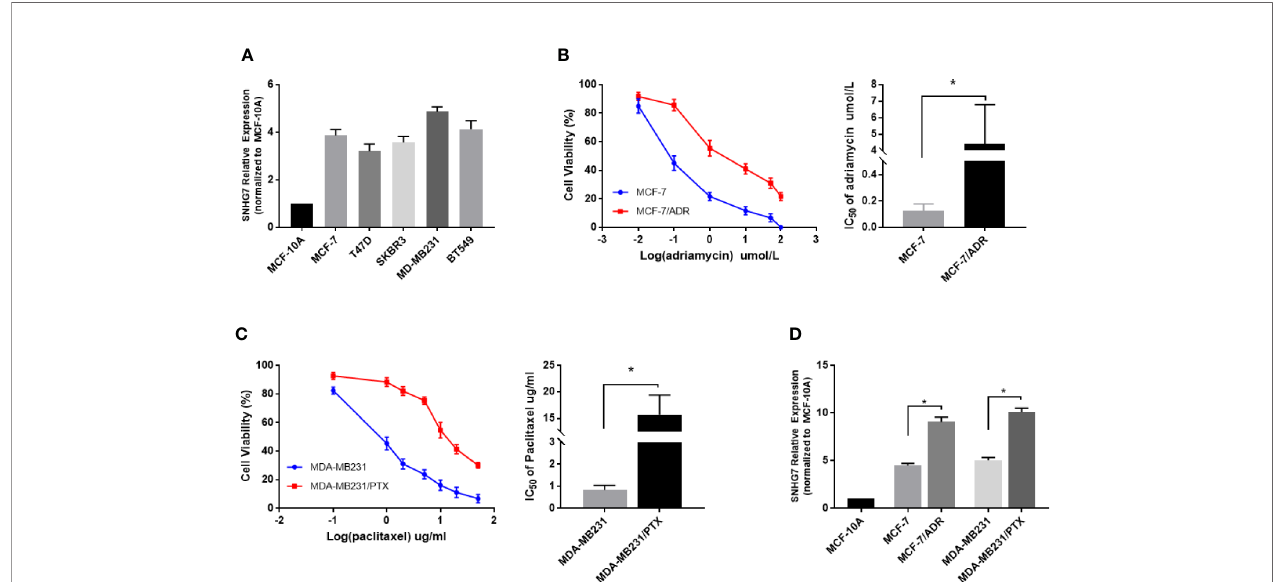
FIGURE 2 | LncRNA SNHG7 was highly expressed in chemoresistant breast cancer cells. (A) The expression of SNHG7 in 5 breast cancer cell lines (MCF-7, T47D, SKBR3, MD-MB231, BT549) and normal human mammary gland epithelial cell line (MCF-10A) determined by qRT-PCR. (B) The viability of MCF-7/ADR and the parental MCF-7 cells, and the IC 50 values of adriamycin were determined by MTT assay after exposure to different concentrations of adriamycin for 48 h. (C) The viability of MDA-MB-231/PTX cells and the parental MDA-MB-231 cells,and the IC 50 values of paclitaxel were determined by MTT assay after exposure to different concentrations of paclitaxel for 48 h. (D) The lncRNA SNHG7 expression level was increased in chemoresistant cell lines (MCF-7/ADR and MDA-MB-231/PTX) compared with parental cell lines (MCF-7 and MDA-MB-231). *P < 0.05.